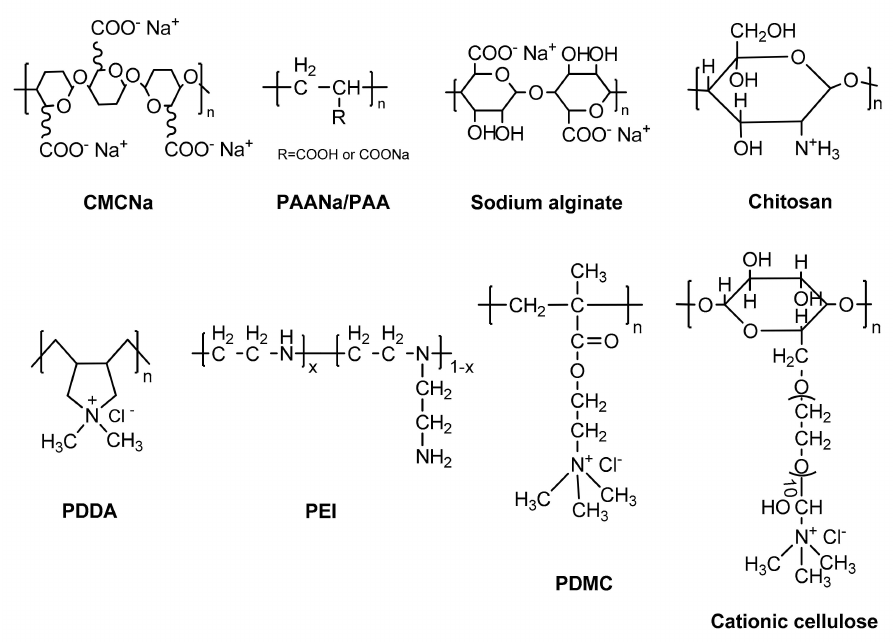
Figure 9. Chemical structures and abbreviations of common polyelectrolytes.